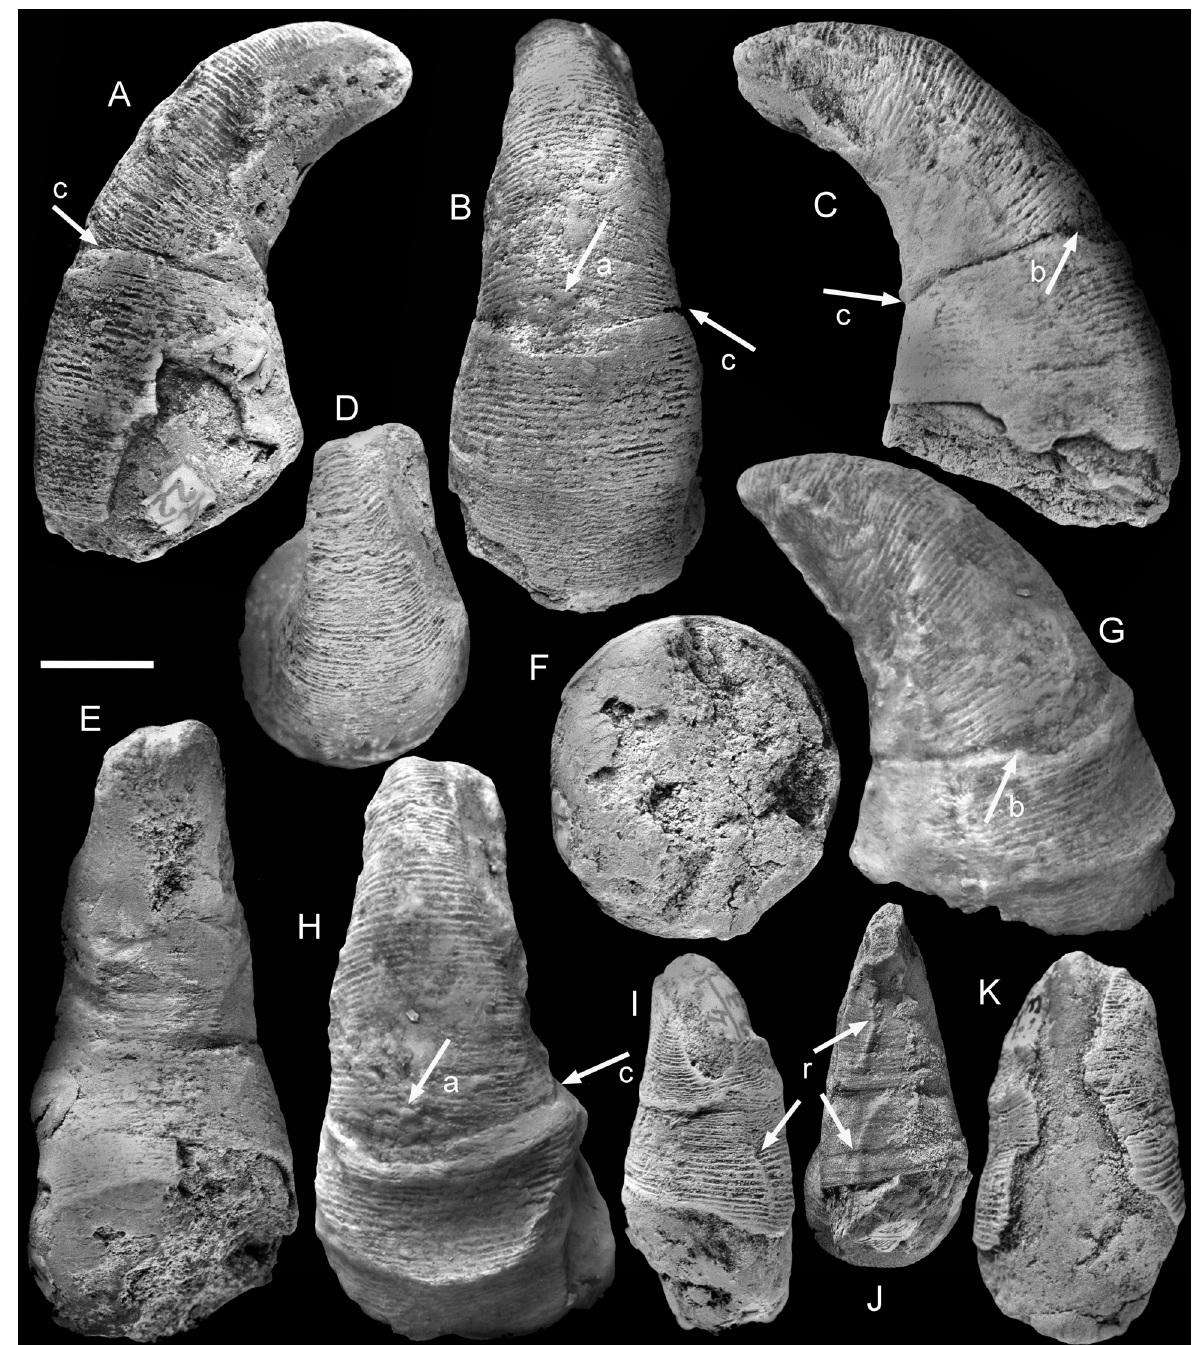
Fig. 1. Pollicina corniculum (Eichwald, 1860). Ordovician, Darriwilian, Kunda Stage, Popowka or Pulkowa [=Pulkovo], St Petersburg, Russia. A–F , lectotype, PSM 4/22: A, lateral view; B, supra­apical surface; C, lateral view; D, supra­apical surface at apex, with adherent matrix on right side; E, sub­apical surface; F, apertural view. G , H , replica of lectotype, PSM 4/22, showing prominent comarginal rugae: G, oblique lateral view; H, supra­apical surface. I , K , replica of paralectotype, PSM 4/23. J , CNIGRM 15692 (380/10903), sub­apical surface showing irregular longitudinal ridges. Arrow a locates equivalent points in B and H. Arrow b indicates equivalent points in C and G. Arrow c indicates the prominent transverse growth dislocation in A–C, H. Arrow r indicates ridges perpendicular to margin in I, J. Scale bar = 5